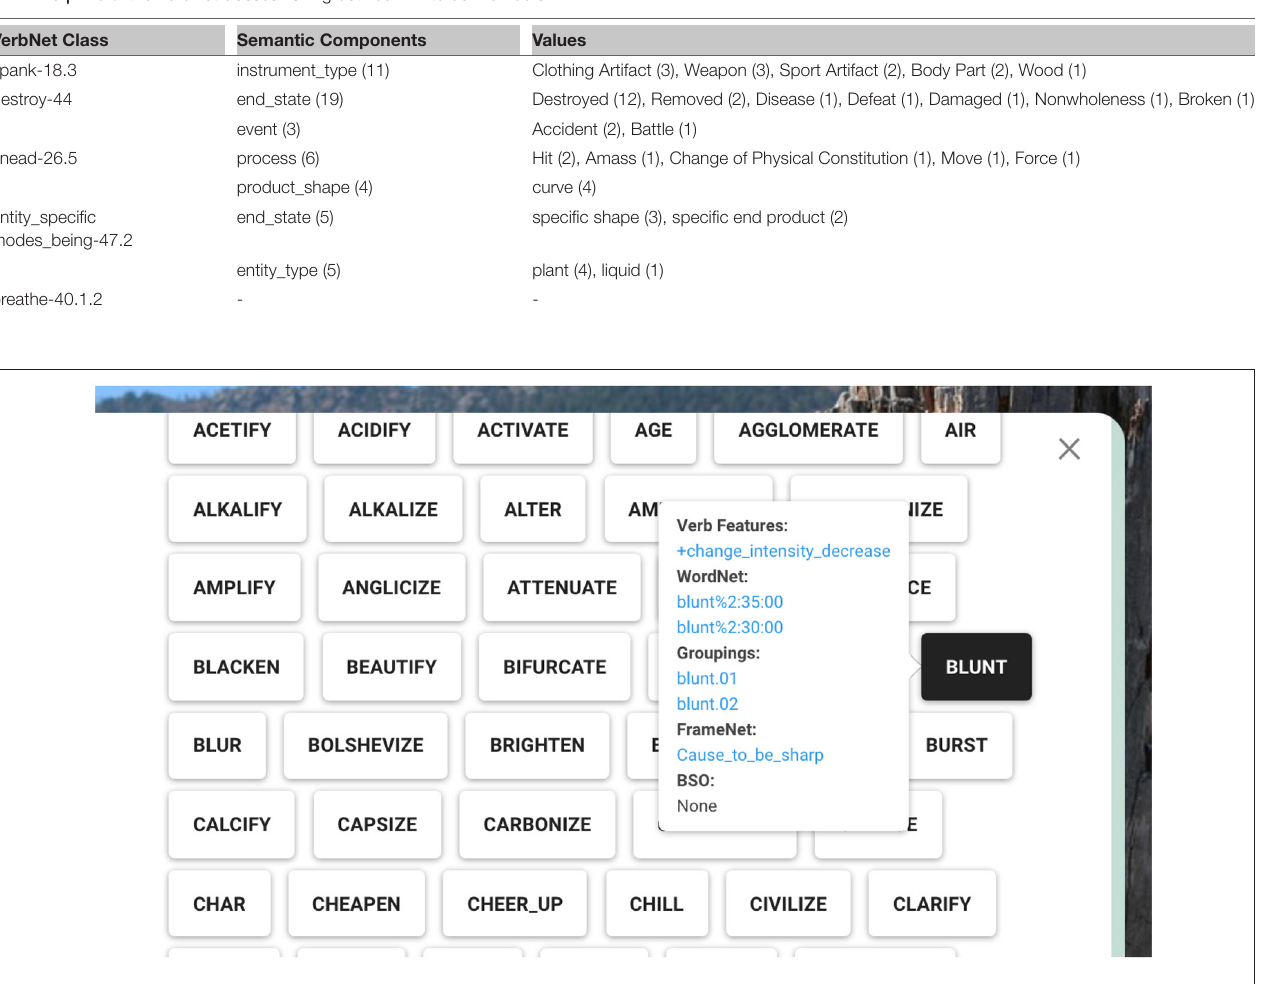
FIGURE 9 | Verb-specific features popping up as a result of hovering over the verb